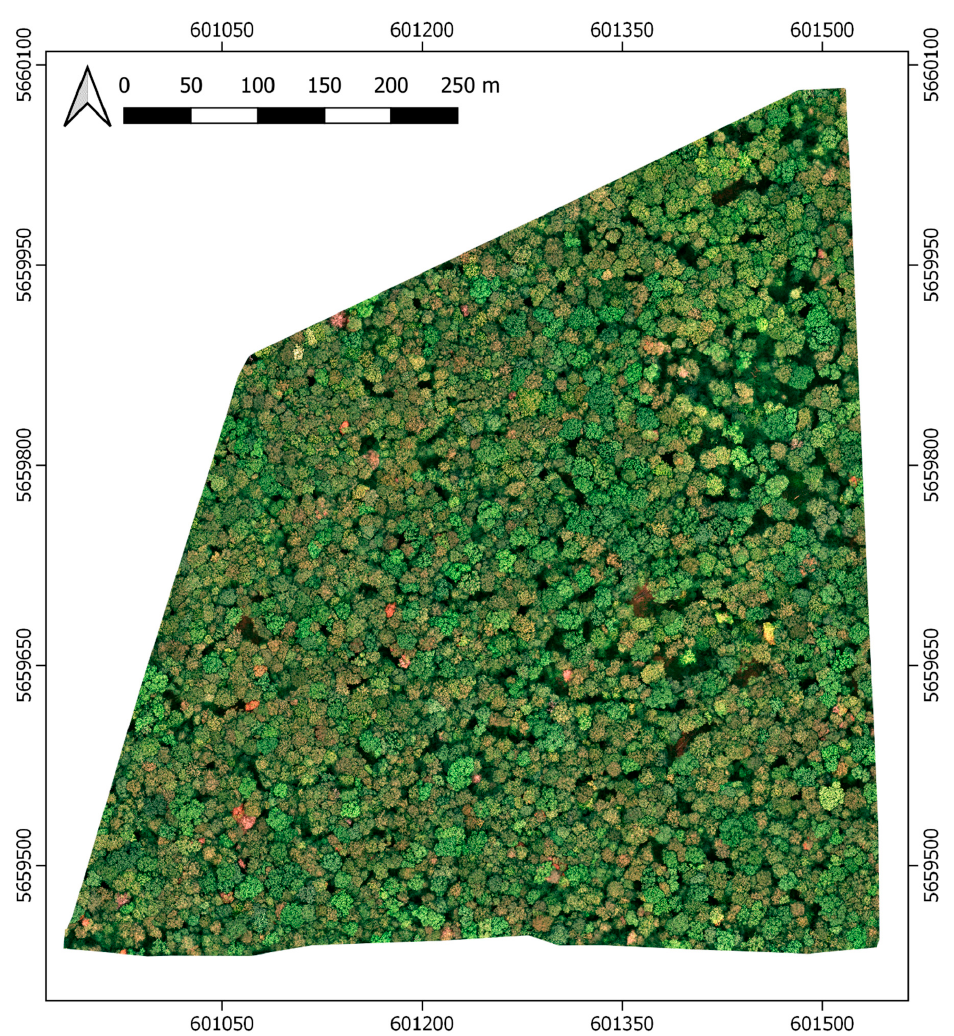
Figure 2. The Huss site in September 2019. The dimensions of the site are approximately 550 m